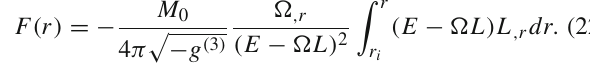
Fig. 12 Images of the circular orbits in the inner accretion disk for the strongly naked singularity with γ = 0 . 48. The observer is located at r = 5000 M and at the inclination angle i = 80 ◦ . We illustrate the variety of possible images by considering several successive orbit posi-